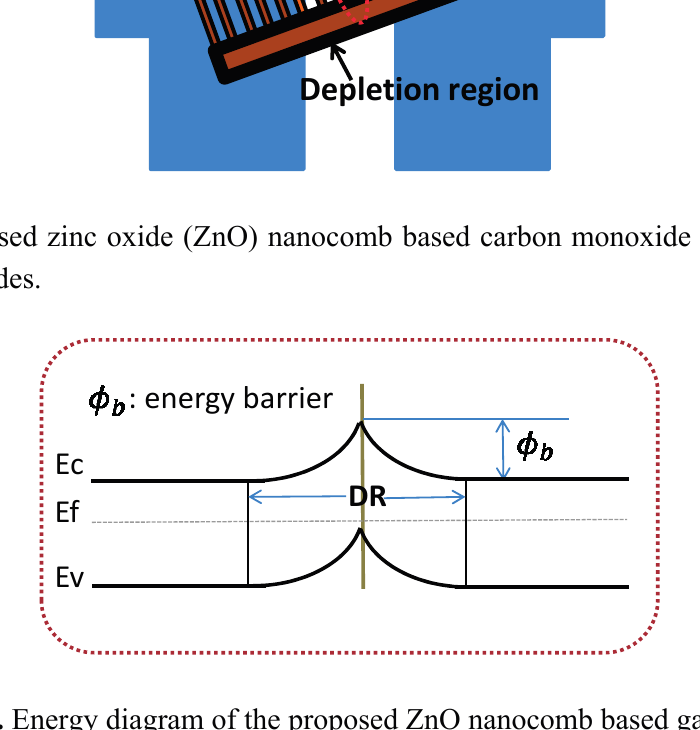
Figure 2. Energy diagram of the proposed ZnO nanocomb based gas